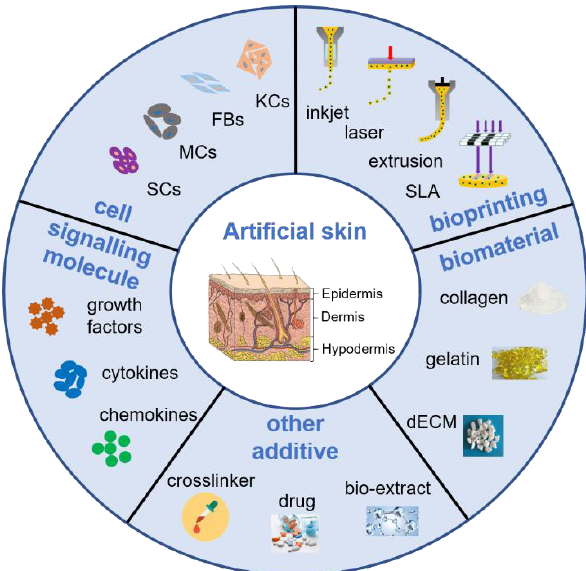
Figure 1. Schematic representation of the main requirements related to 3D bioprinting for skin regeneration. The artificial skin was printed by inkjet, laser, extrusion or stereolithography (SLA) bioprinting technologies with a cell-encapsulating bioink, which consists of biomaterials, constituent cells, stem cells and signaling molecules, or acellular bioink which contains biomaterials only. The mechanical property of artificial skin was enhanced by adding crosslinker, and some drugs or bio-extract were adding to obtain multifunctional skin for wound healing, such as anti-inflammatory and antibacterial. Abbreviations: KCs: Keratinocytes, FBs: Fibroblasts; MCs: Melanocytes, SCs: Stem cells, dECM: Decellularized extracellular matrix.